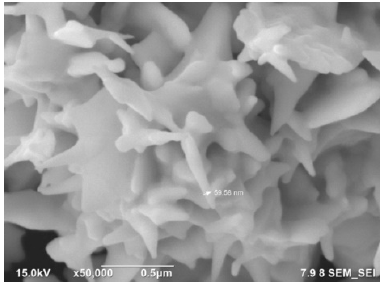
Figure 6. SPCE/AuNS working electrode surface prepared with optimal configuration (applied potential of − 0.2 V vs. Ag/AgCl for 1200 s using a precursor of 10 mM) characterized with FE-SEM with the magnification of 50,000×.